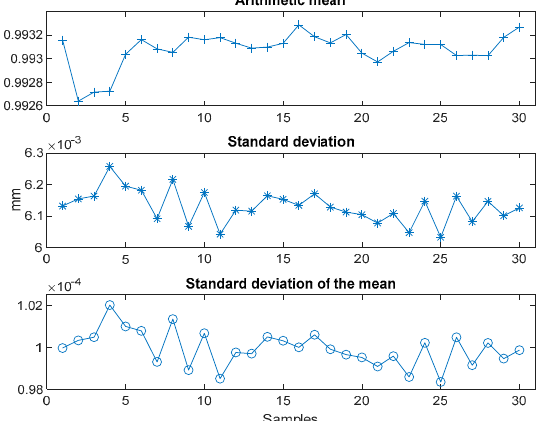
Figure 21. Repeatability tests for circular paths carried out 30 times with F1000.